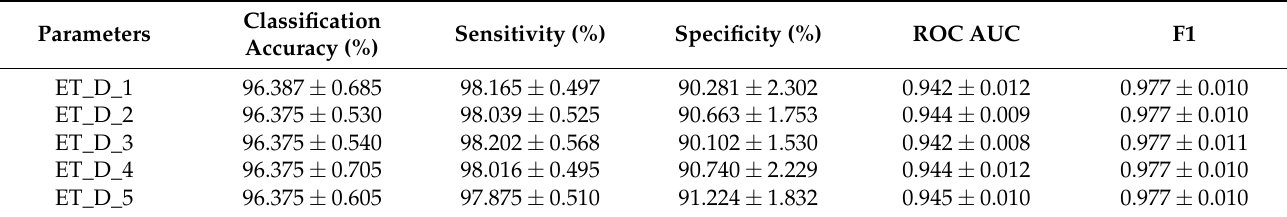
Table 7. Best results for the extremely randomized trees algorithm (dynamic analysis).